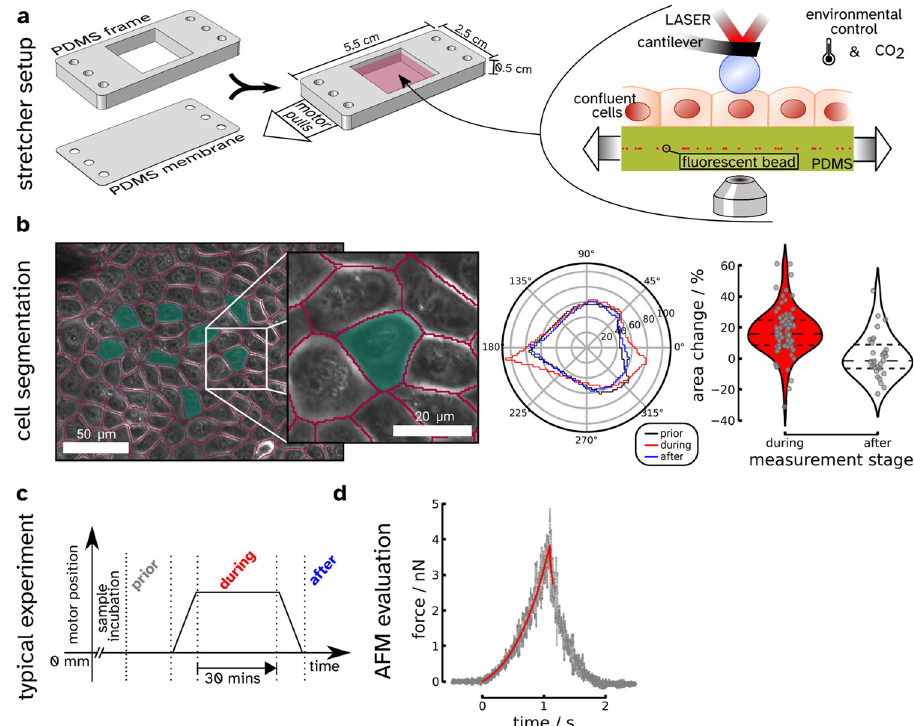
Fig. 1 Overview of the cell stretcher experiment and the measured changes in cell properties due to strain. a Scheme illustrating the design and production of the polydimethylsiloxane (PDMS) measurement chamber and the fi nal assembly. Cells are cultured to con fl uence and then strained along the longer axis of the chamber. The chamber is mounted on an optical microscope to perform AFM measurements under optical inspection and physiological cell culture conditions. b Left: example of cell segmentation of phase-contrast images carried out by Cellpose. Cell-cell contacts are marked in magenta, and the probed cells are colored in green. The change of the cell shape is followed over time during stretching. Right: change of the cell's projected area during (red) and after application of strain (white). Each point represents a single measured cell. The thick dashed line corresponds to the median, while the thin dashed lines refer to the upper and lower quartile, respectively ( n = 90 cells during, n = 30 cells after). c Motor position and applied strain over the course of the experiment. d Typical indentation-retraction curve before the strain was applied (gray dots) together with the fi t of equation (1) (red line, maximum indentation depth δ max ¼ 2 : 2 μ m, see Supplementary Fig. 8 for an overview of δ max